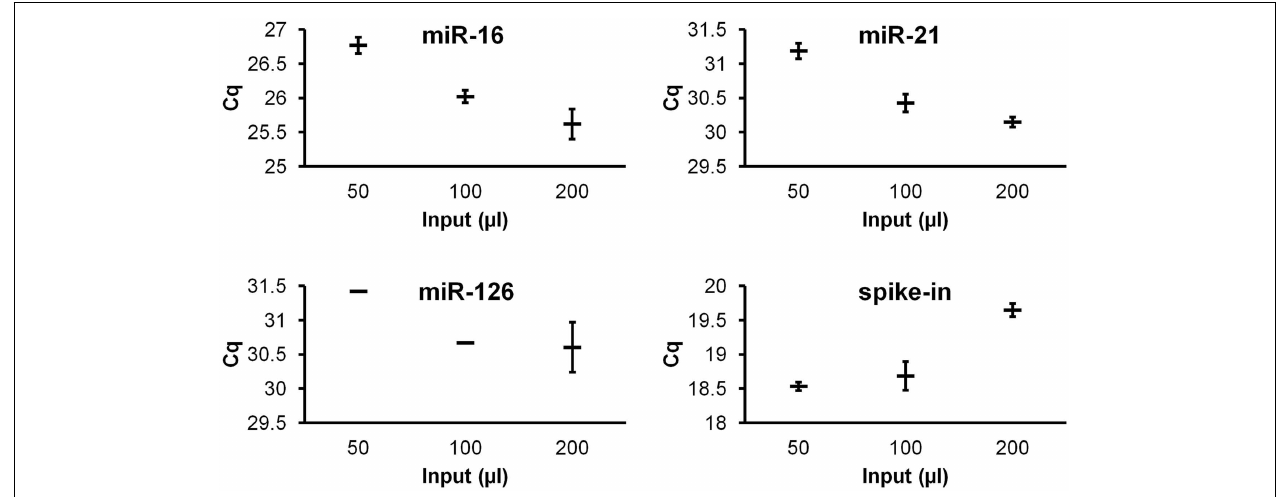
Range of Cq values for higher-abundance miR-16, lower-abundance miRs-21 and -126, and spiked-in cel-miR-39 (same input amount for each isolation) are shown.